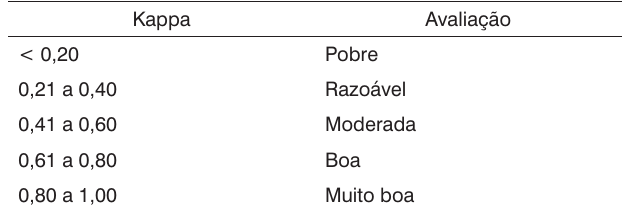
Tabela 1. Avaliação do